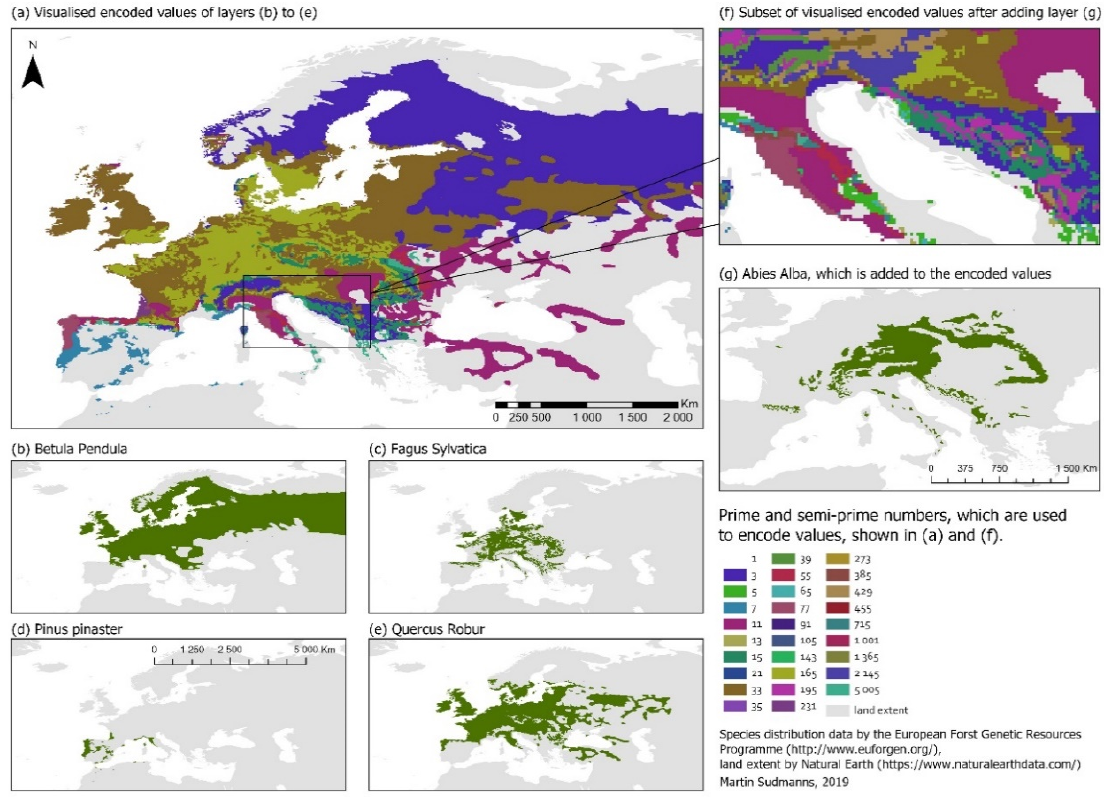
Figure 6. Tree species distribution across Europe requires handling of overlapping regions. In this case, the species Betula Pendula ( b ), Fagus Sylvatica ( c ), Pinus pinaster ( d ), and Quercus Robur ( e ) were encoded with prime numbers as shown in the map ( a ). Although only one value per cell is required, the spatial distribution of all species is preserved and can be reconstructed without loss. A simple multiplication allows new species to be added, here Abies Alba ( g ), without the need to change the schema of the dataset ( f ). The data is obtained from the European Forest Genetic Resources Program (EUFORGEN) [18].